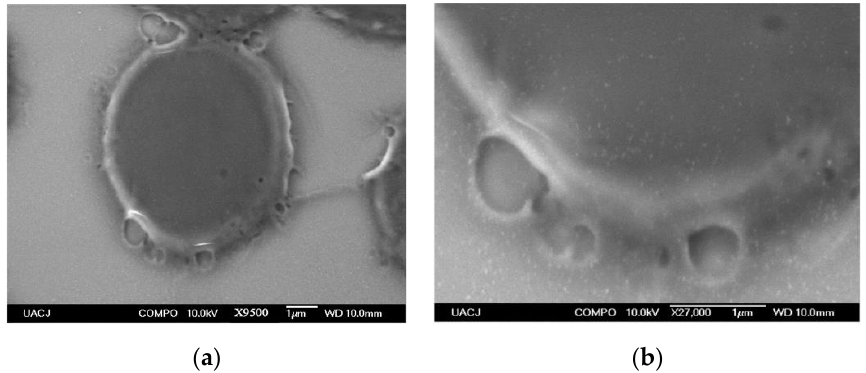
Figure 14. SEM micrographs of ( a ) isolated erythrocyte ghost and ( b ) membrane with AuNPs deposited on its surface.